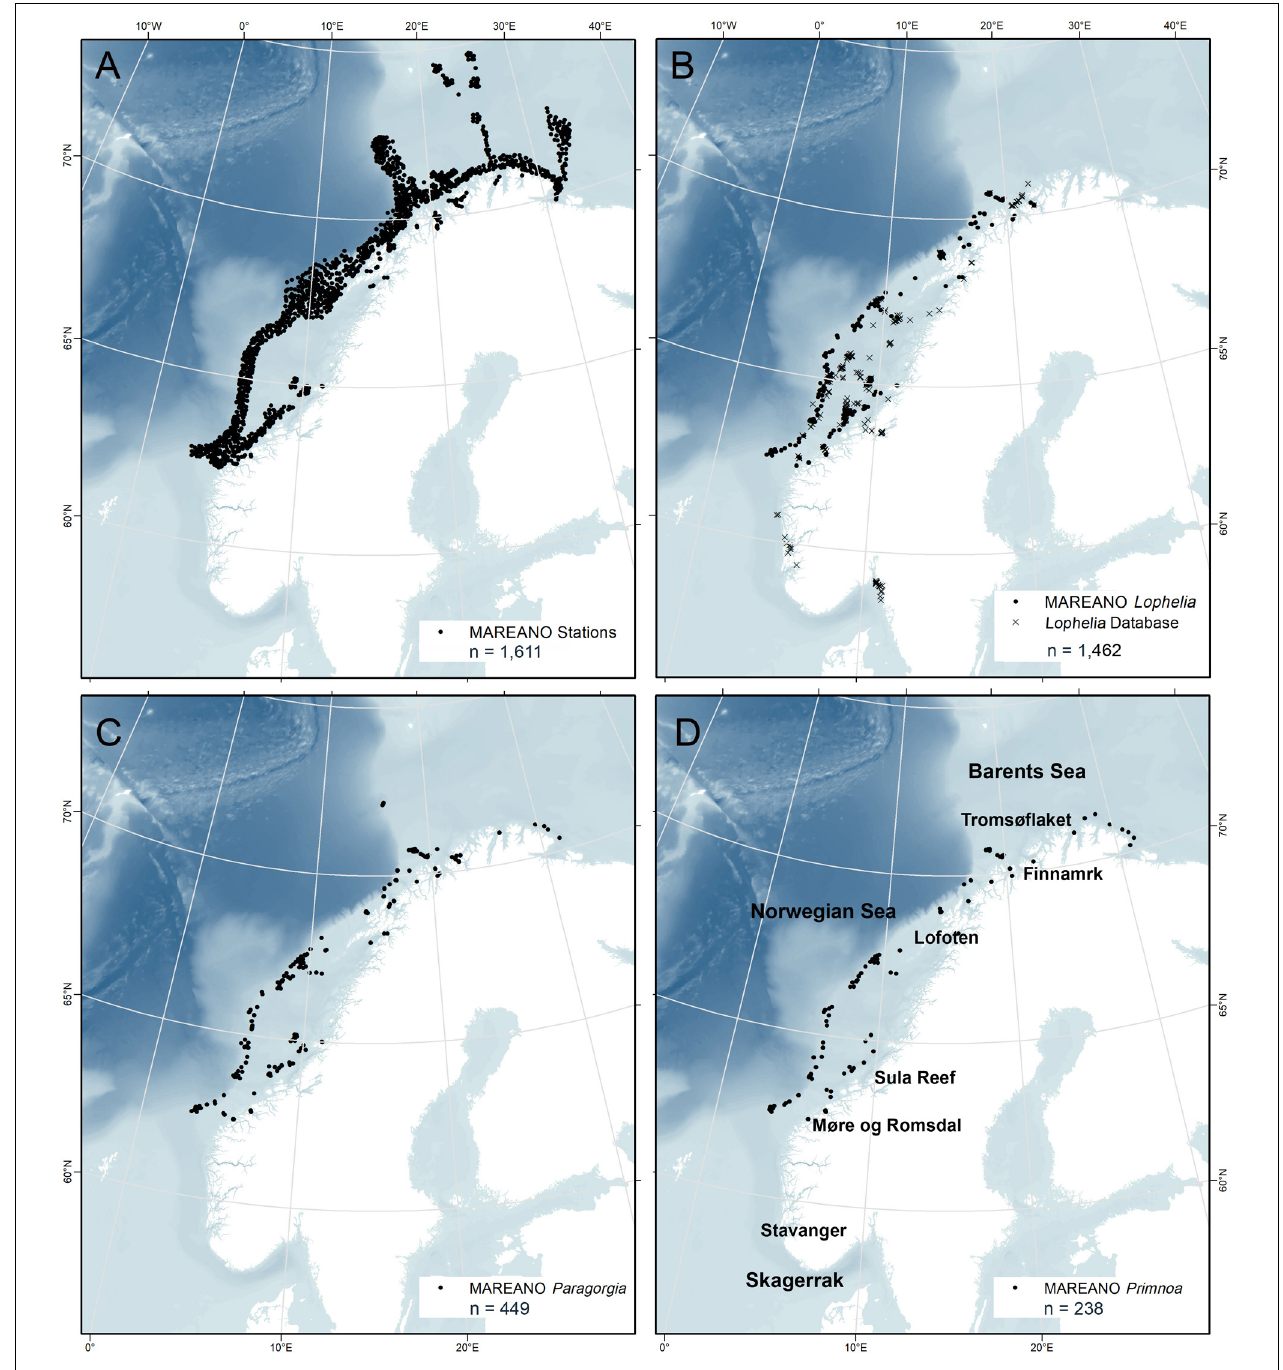
FIGURE 1 | Distribution of all MAREANO video stations (A) and all coral presence points for Lophelia pertusa (B) , Paragorgia arborea (C) , and Primnoa resedaeformis (D) on the Norwegian continental shelf. n = number of presence points.